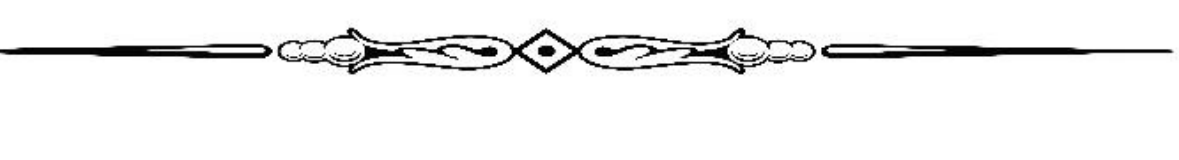
Figure 11 & 12: The snow-white chalky limestones in Abou-Roash area.